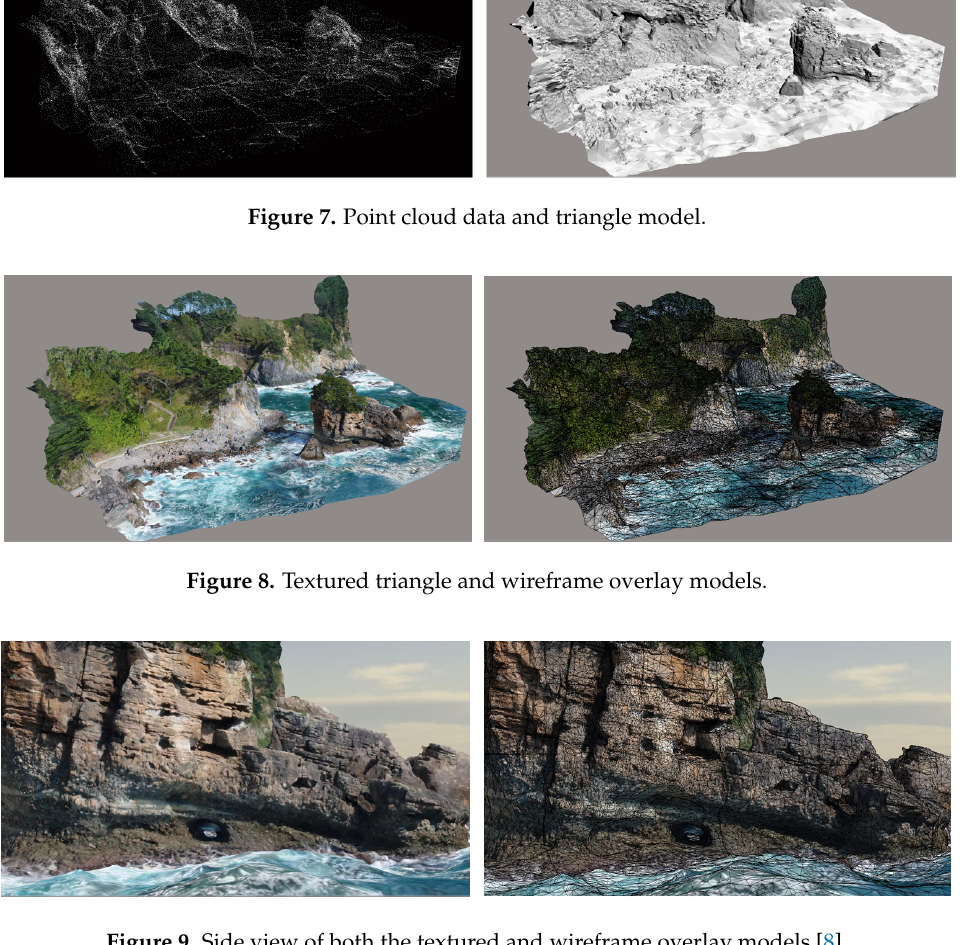
Figure 9. Side view of both the textured and wireframe overlay models.